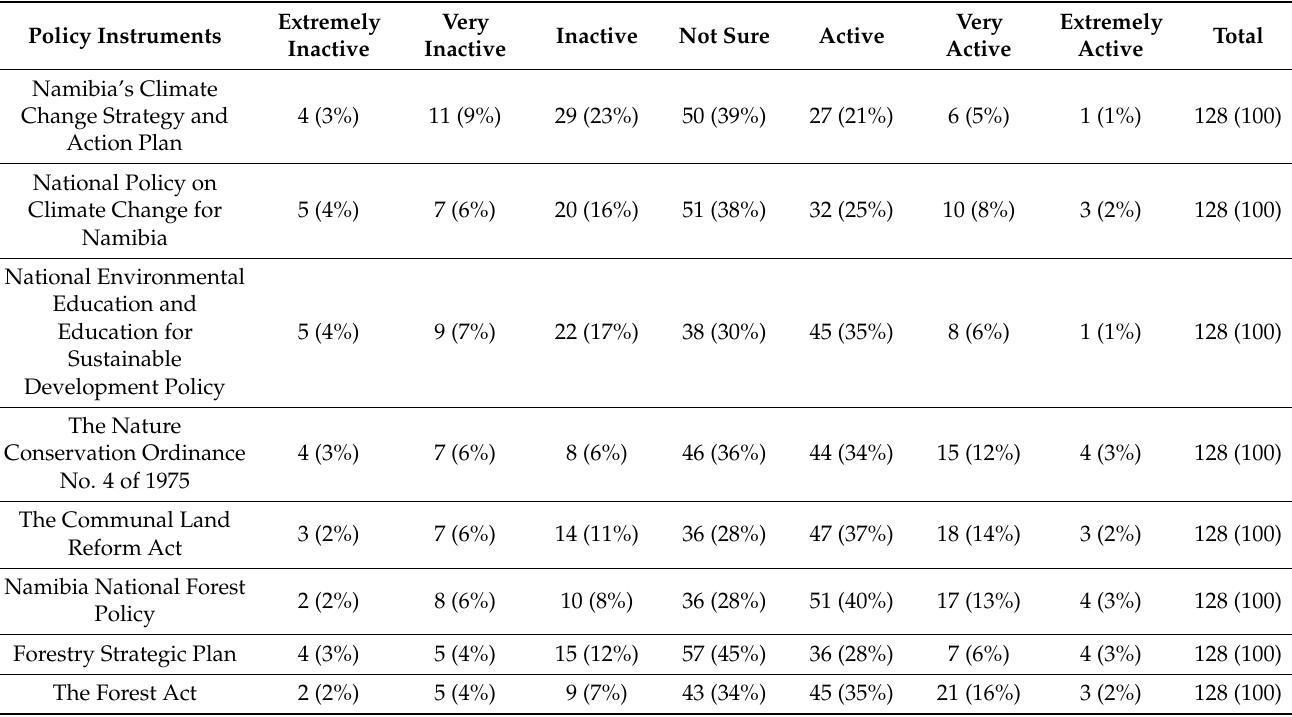
Table 1. The rating of how active the implementation of various policy instruments for climate change adaptation in mopane woodlands in northern